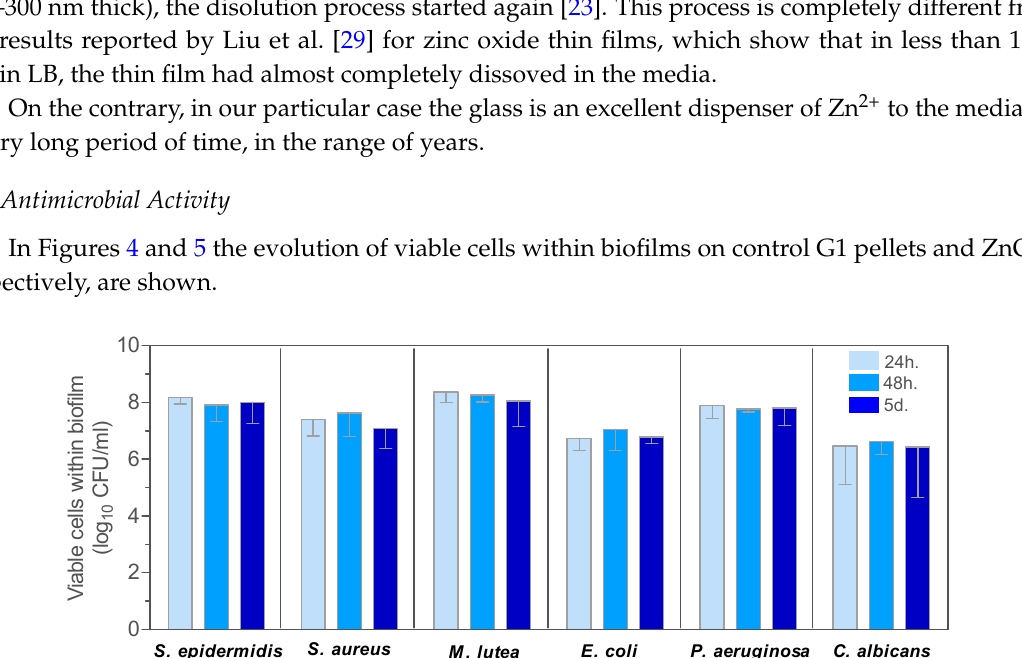
Figure 4. Evolution of viable cells within biofilms developed for 24 h, 48 h, or 5 days on control G1 pellets.